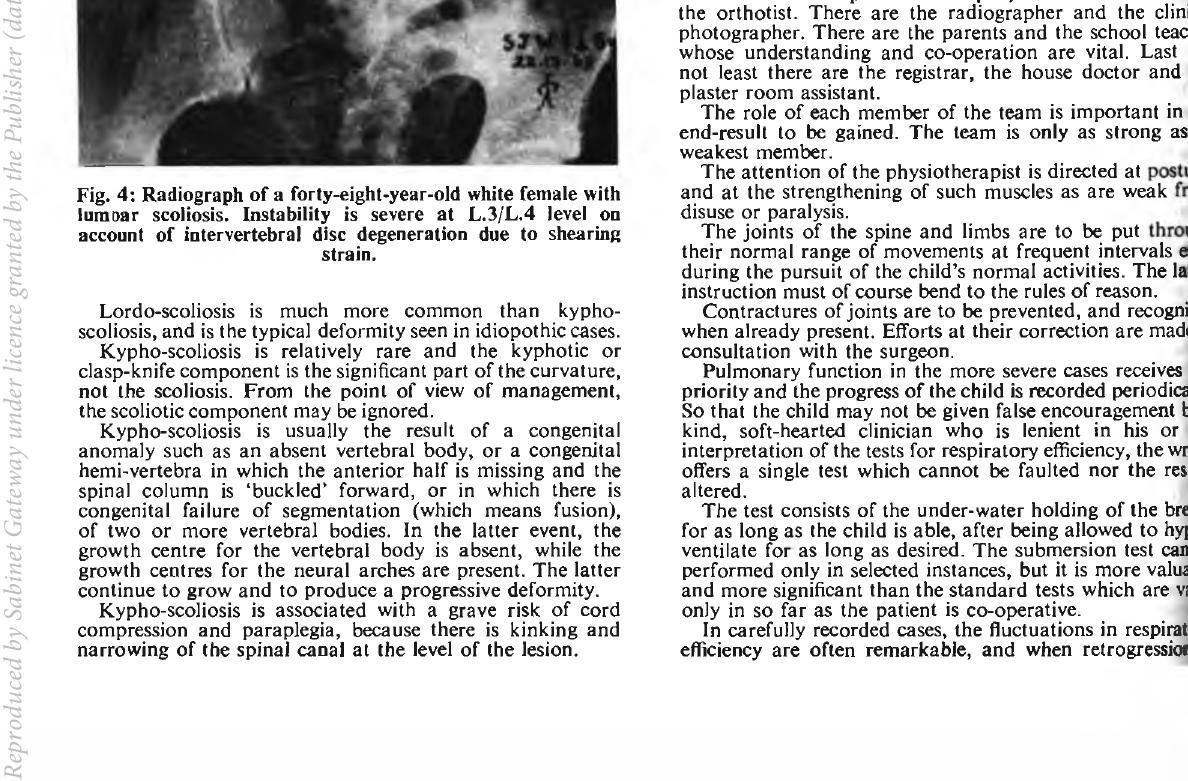
Fig. 4: Radiograph of a forty-eight-year-old white female with lumoar scoliosis. Instability is severe at L.3/L.4 level on account of intervertebral disc degeneration due to shearing